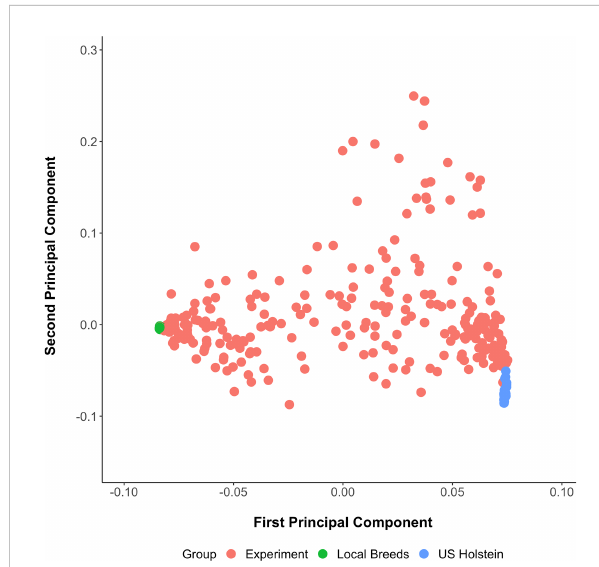
FIGURE 4 Principal component analysis looking at the breed composition (Holstein-Friesians) of cows in the study.